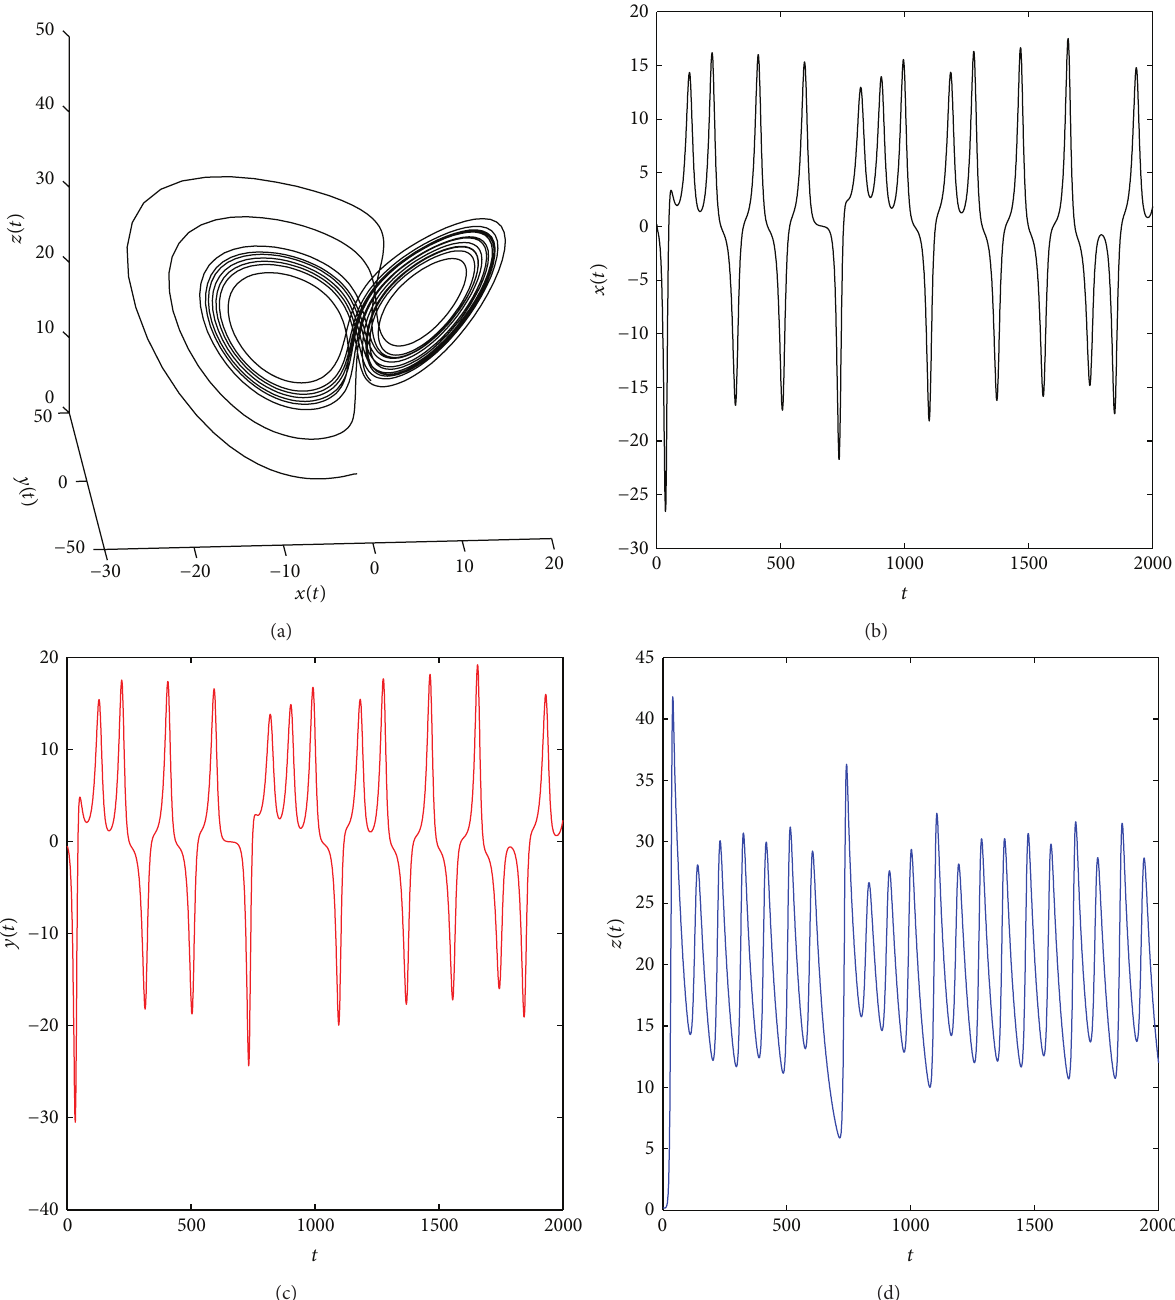
Figure 4: Chaotic attractor of the distributed order fractional Chen system (22) with ( 𝑞 1 , 𝑞 2 ,𝑞 3 ) = (0.85, 0.9, 0.95) and (𝑎, 𝑏,𝑐) = (35,3, 28) . 𝑥 (𝑡 ) = 𝑓 (𝑥 (𝑡 ) , 𝑡 ) ℎ 𝛼 𝑘 𝑘−1 𝑘−1